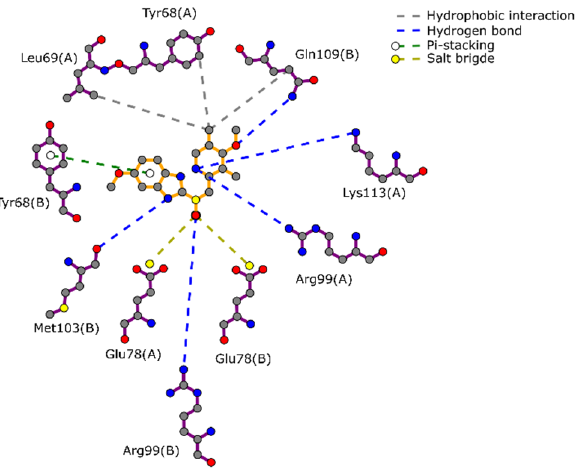
Figure 2. 2D interaction diagram between omeprazole drug and TIM Gl on the interface.